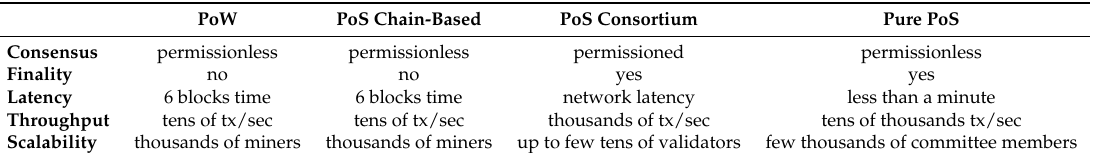
Table 2. Comparison of the three different consensus models: Proof-of-Work, Proof-of-Stake and Pure Proof-of-Stake, based on their main